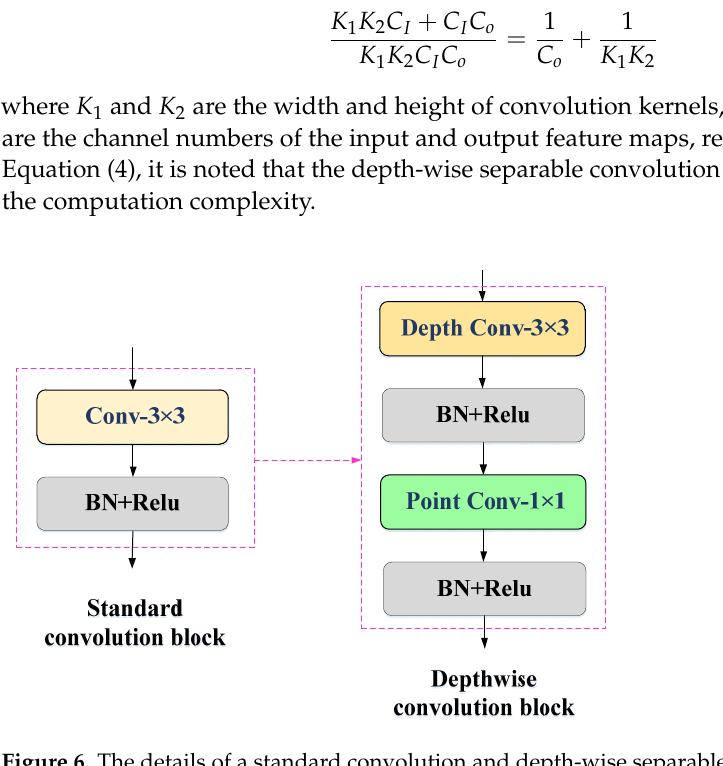
Figure 6. The details of a standard convolution and depth-wise separable convolutional block.